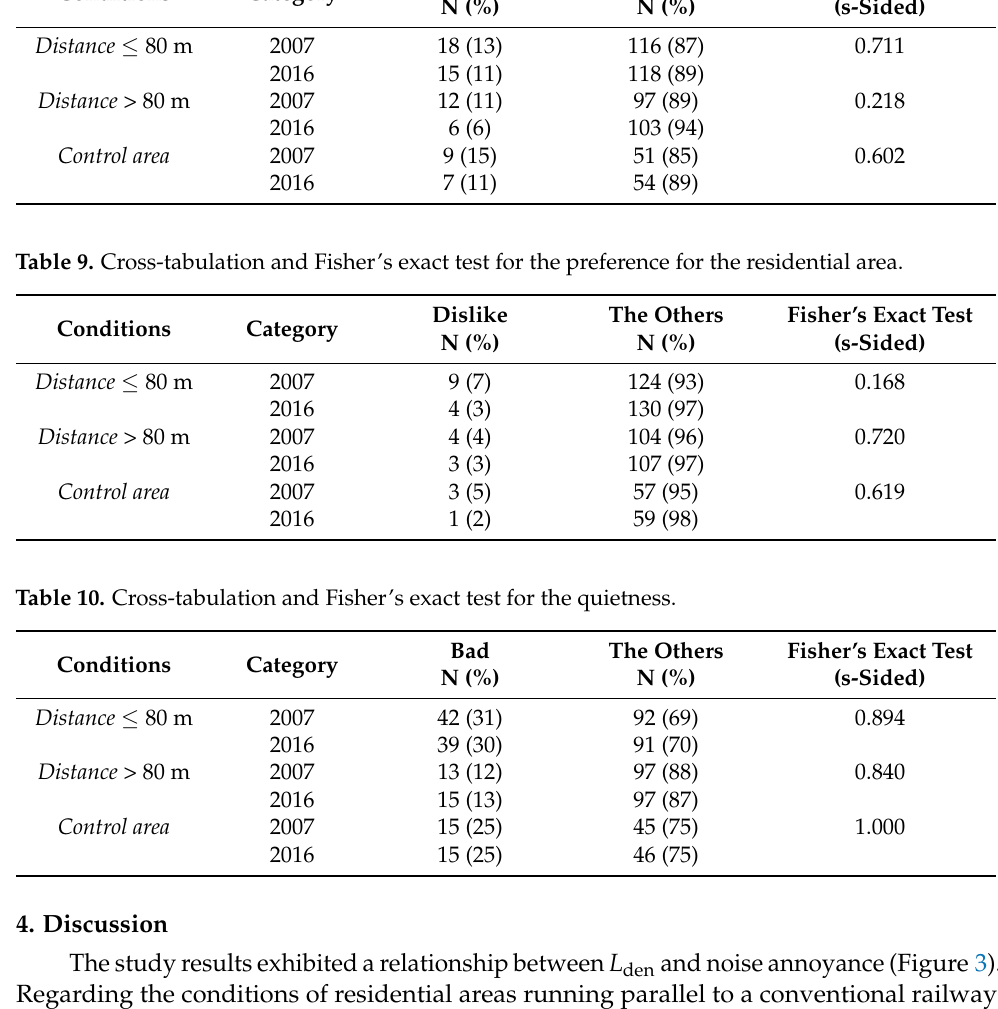
Table 8. Cross-tabulation and Fisher’s exact test for the housing satisfaction. Conditions